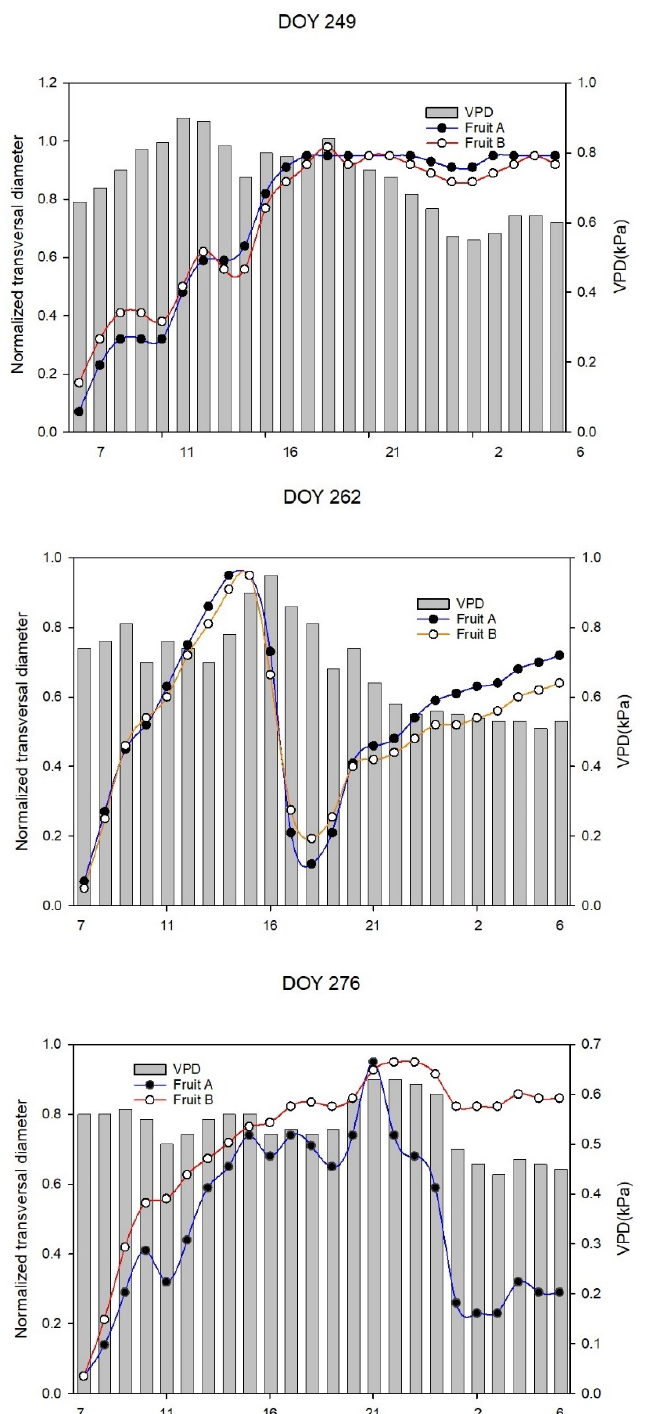
Figure 3. Continuous measurements of transversal diameter of fruit A and fruit B at selected days during the first period of the experiment.